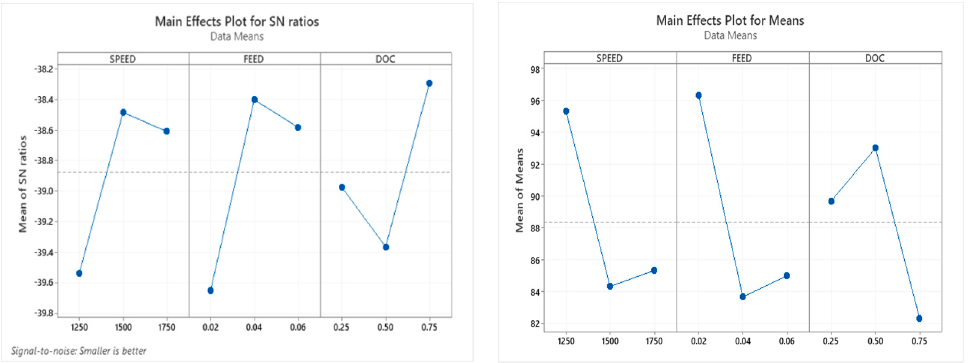
Figure 8. Main effect plot for SN ratio and means for machining time.